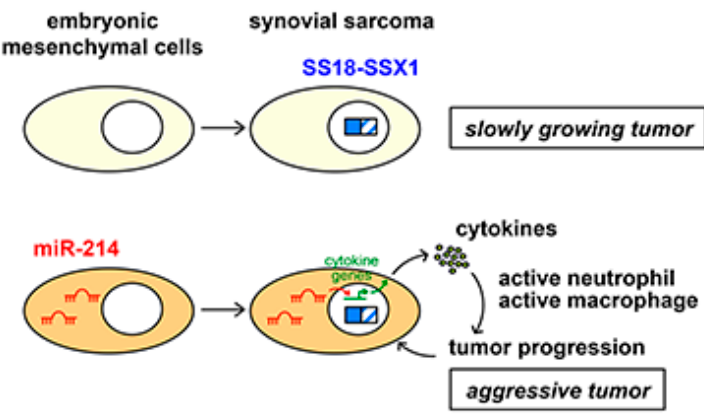
Figure 6. Proposed model of cooperation between SS18-SSX1 and miR-214 . SS18-SSX1 expression in embryonic mesenchymal cells that do not express miR-214 induces slowly growing tumors ( top ). On the other hand, miR-214 upregulates expression of cytokine genes, such as Cxcl15 , that activate neutrophils and macrophages in the tumor microenvironment, resulting in an aggressive nature of synovial sarcoma ( bottom ).